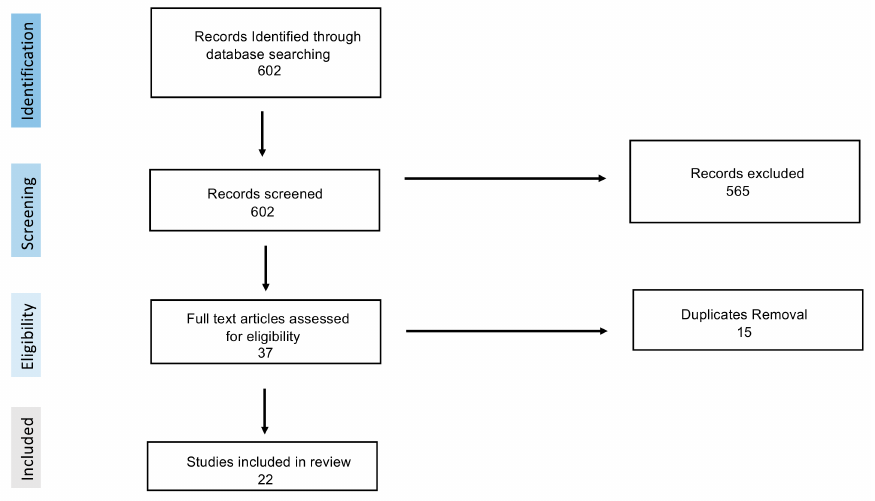
Figure 6. Flow chart of identification of clinical trials included in this systematic